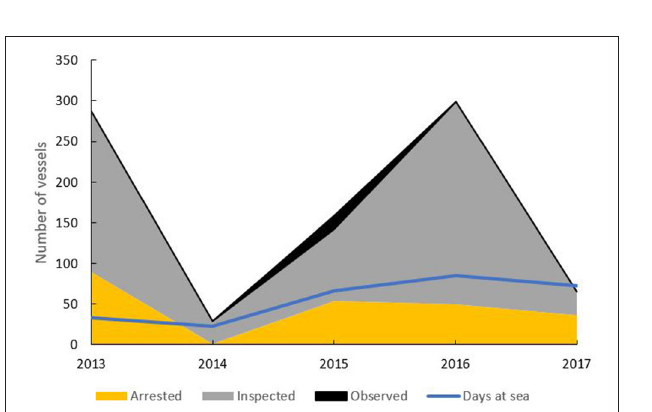
FIGURE 9 | Total illegal unreported and unregulated fisheries catches from Guinea Bissau. Catch data reported to FAO are of the order of 6,700 tons per year and cannot be displayed in the chart. Artisanal catches for 2016 and 2017 were estimated by extrapolating the trend for 2013–2015, subsistence catches for 2016 and 2017 were estimated by extrapolating the trend from 2011 onwards. Reported landings for 2016 and 2017 were assumed constant since